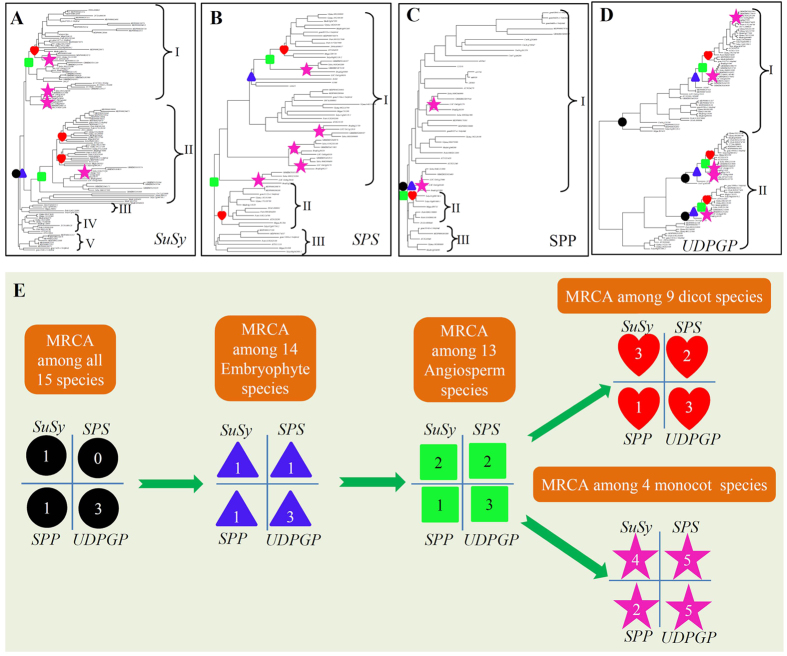
Phylogenetic analyses and evolutionary history of the SuSy, SPS, SPP and UDPGP families.(A–D) Phylogenetic analyses of the SuSy, SPS, SPP and UDPGP families, respectively, in 15 species including 4 monocot and 9 dicot plants as well as 1 spikemoss and 1 algae. Domain amino acid sequences were achieved to construct phylogenetic trees using the bootstrap method with a heuristic search of the PAUP 4.0 b8 program. The results were confirmed by the Bayesian analyses. We defined ancestral units according to the description by Shiu et al. (2004)38. Their enlarged phylogenetic trees are shown in Supplementary Fig. S2 (A–D), respectively. (E) Evolutionary history of the four gene families in 15 organisms. Black circles represent the MRCA units among all 15 organisms; blue triangles indicate the MRCA units among 14 embryophyte species and green squares show the MRCA units among angiosperm species. Red heart shapes and pink stars represent the MRCA units in 9 dicot and 4 monocot plants, respectively.